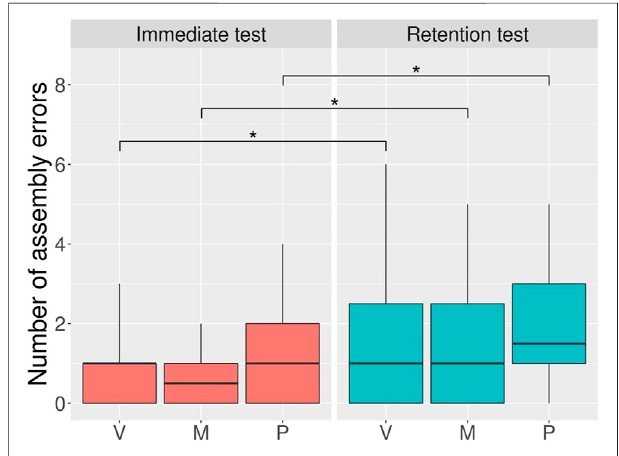
FIGURE 9 | Numbers of assembly errors. *means signi fi cant difference ( p <